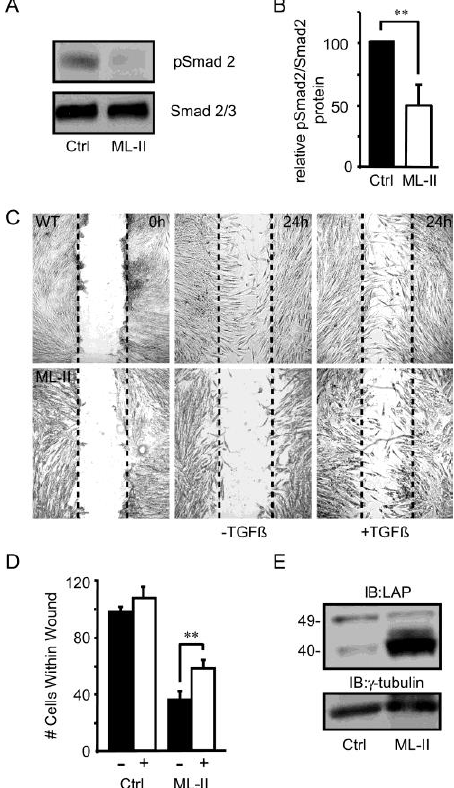
Figure 1. ML-II fibroblasts exhibit reduced transforming growth factor beta 1 (TGF β 1) signaling accompanied by impaired TGF β 1-dependent wound closure. ( A ) Western blot analysis of control and ML-II human fibroblast lysates using antibodies against human Smad 2 / 3 and phosphorylated Smad 2. ( B ) Quantification of the relative intensity of phosphorylated Smad 2 vs. Smad 2 / 3 protein in control and ML-II cells (n = 3), ** p ≤ 0.01. ( C ) Representative images of wound healing assays using